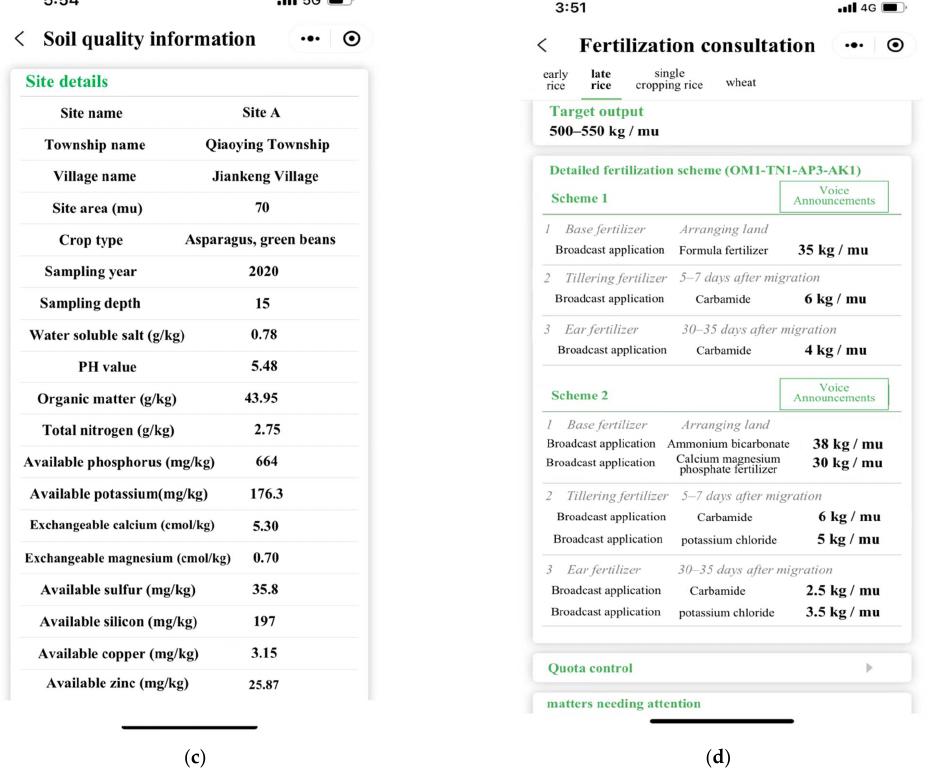
Figure 1. Screenshots of “Zhe’yang’shi” WeChat application. Notes: Subfigure ( a ) shows the screenshot of policy information, farmers can find the related policies on land and fertilizer. In subfigure ( b ), farmers can search their farm by entering names or phone numbers. Subfigure ( c ) shows the detailed soil quality information of every site. Subfigure ( d ) shows the fertilization consultation information, which provides farmers with the formula fertilization plans.